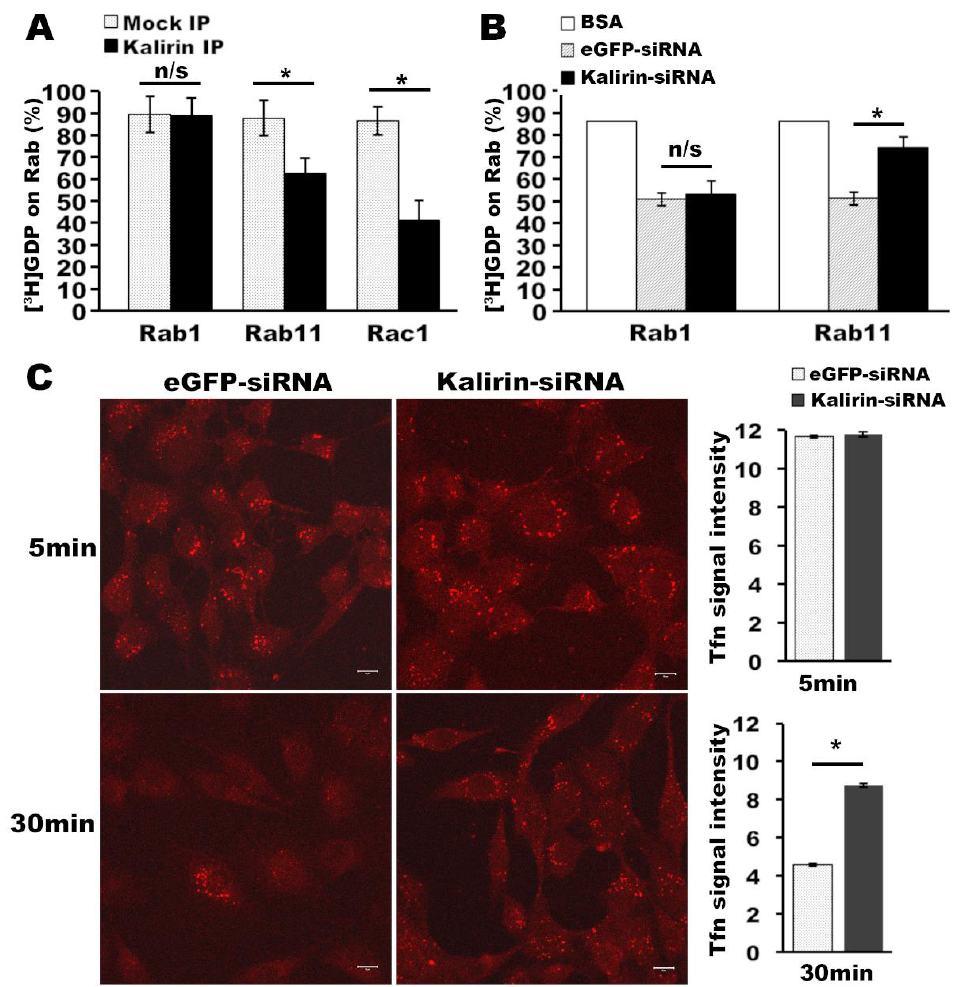
Figure 3. Kalirin regulates the activation of Rab11 and endocytic recycling of transferrin. ( A ) Kalirin immunoprecipitates containing GEF activities on Rab11. Triton solubilized cellular membranes from cells transfected with pEAK-His-myc-kalirin7 or empty vector were used for immunoprecipitation with anti-myc antibodies. Precipitated proteins were used for the [ 3 H]GDP release assay as described in Methods. Mean ± SD percentages of [ 3 H]GDP remaining on GST-Rab1-His, GST-Rab11-His, and GST-Rac1 were graphed (n = 3, two-tailed Student’s t -test: n / s, not significant, * p < 0.01). ( B ) Knockdown of kalirin reduced Rab11GEF activities in cellular membranes. After knocking down kalirin in NRK cells as in (2A), cellular membranes were prepared and extracted in GEF assay buffer containing triton X-100. Equal amounts of solubilized membranes from cells treated with eGFP-siRNA and kalirin-siRNA were used for [ 3 H]GDP release from GST-Rab1-His and GST-Rab11-His as above. BSA is a no-GEF control (n = 3, Mean ± SD, two-tailed Student’s t -test: n / s, not significant, * p < 0.01). ( C ) Synchronized uptake and recycling of Alexa568-transferrin was performed with siRNA-treated NRK cells for indicated times. After uptake, NRK cells on glass coverslips were processed for fluorescent microscopy. Shown are confocal images. Scale bar: 10 µ m. Signal intensities of Alexa568-transferrin and the corresponding background of the images for each condition were measured using NIH ImageJ. After subtracting the background, the mean values of Alexa568-transferrin signals were calculated and plotted (n = 33 cells for kalirin-siRNA and 34 cells for eGFP-siRNA for 5min incubation, n = 35 cells for kalirin-siRNA and 31 cells for eGFP-siRNA for 30min incubation; Mean ± SD, two-tailed Student’s t -test: * p <